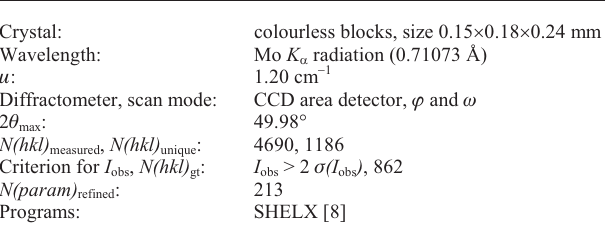
Table 1. Data collection and